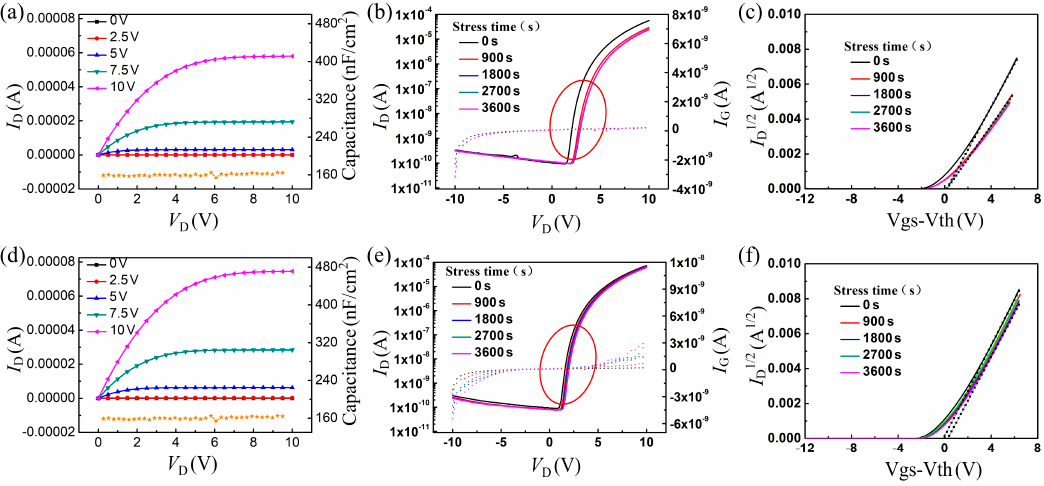
Figure 5. Bias stability of the TFT with ZrO 2 film fabricated by spin-coating of 0.3 M precursor for 6 times. ( a ) Output curves and gate capacitance as a function of voltage. ( b ) Transfer curves with gate-leakage current curves of positive bias stress. ( c ) Plots of sqrt I ds (drain/source current) versus gate overdrive of positive bias stress. ( d ) Output curves and gate capacitance as a function of voltage. ( e ) Transfer curves with gate-leakage current curves of negative bias stress. ( f ) Plots of sqrt I ds (drain/source current) versus gate overdrive of negative bias stress.